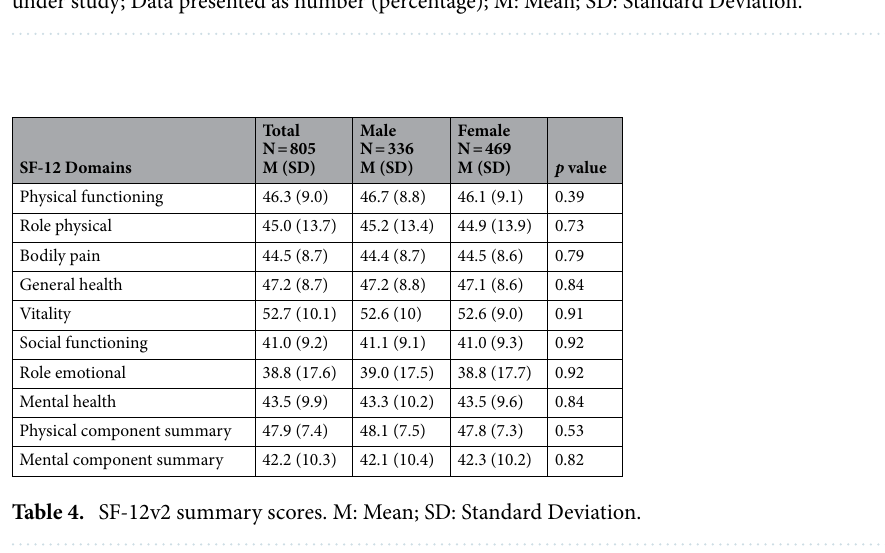
Table 3. Depression, anxiety and stress characteristics of subjects with LBP (N = 698). N: number of subjects under study; Data presented as number (percentage); M: Mean; SD: Standard Deviation.